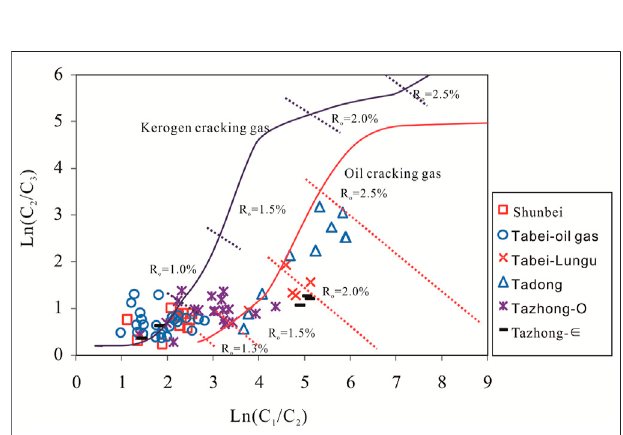
FIGURE 9 | Ln (C 1 /C 2 )-Ln (C 2 /C 3 ) of deep natural gas in Tarim. (base map according to Li, et al.,